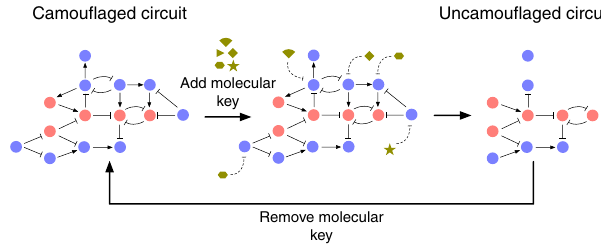
Fig. 3 Circuit camou fl age. The red nodes denote genes of the correct circuit while the blue nodes are the genes of the camou fl aging circuit. The addition of a “ molecular key ” represses or removes the effects of genes of the camou fl aging circuit that are incident on the correct circuit, leaving the correct circuit to function. Only nodes repressed by the molecular key and that are only incident on the correct circuit have been removed in the uncamou fl aged circuit. Nodes targeted by the key but which still have an incident node from the correct circuit have been kept, as these nodes will act as a sink for the proteins from the